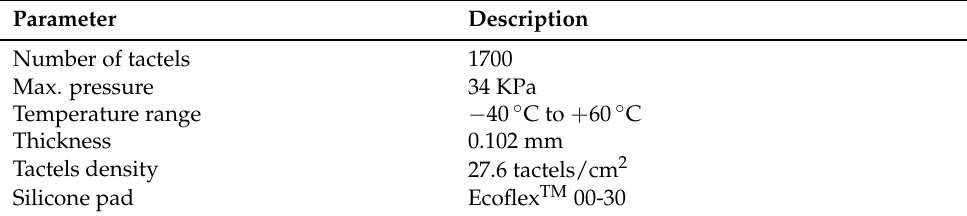
Figure 2. Experimental setup used to obtain a forearm dataset. A description of the elements of the underactuated gripper attached to the forearm measurement device. Table 1. Features of Tekscan 6077 tactile sensor and silicone pad.